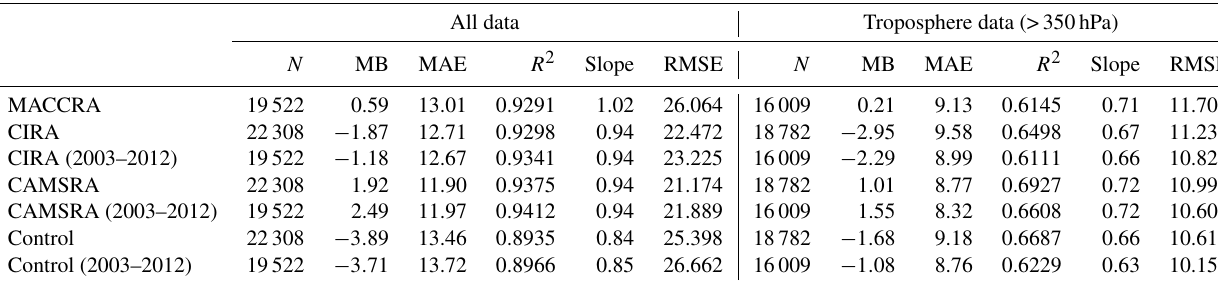
Table 4. Linear regression of ozone between observations and models. All data Troposphere data